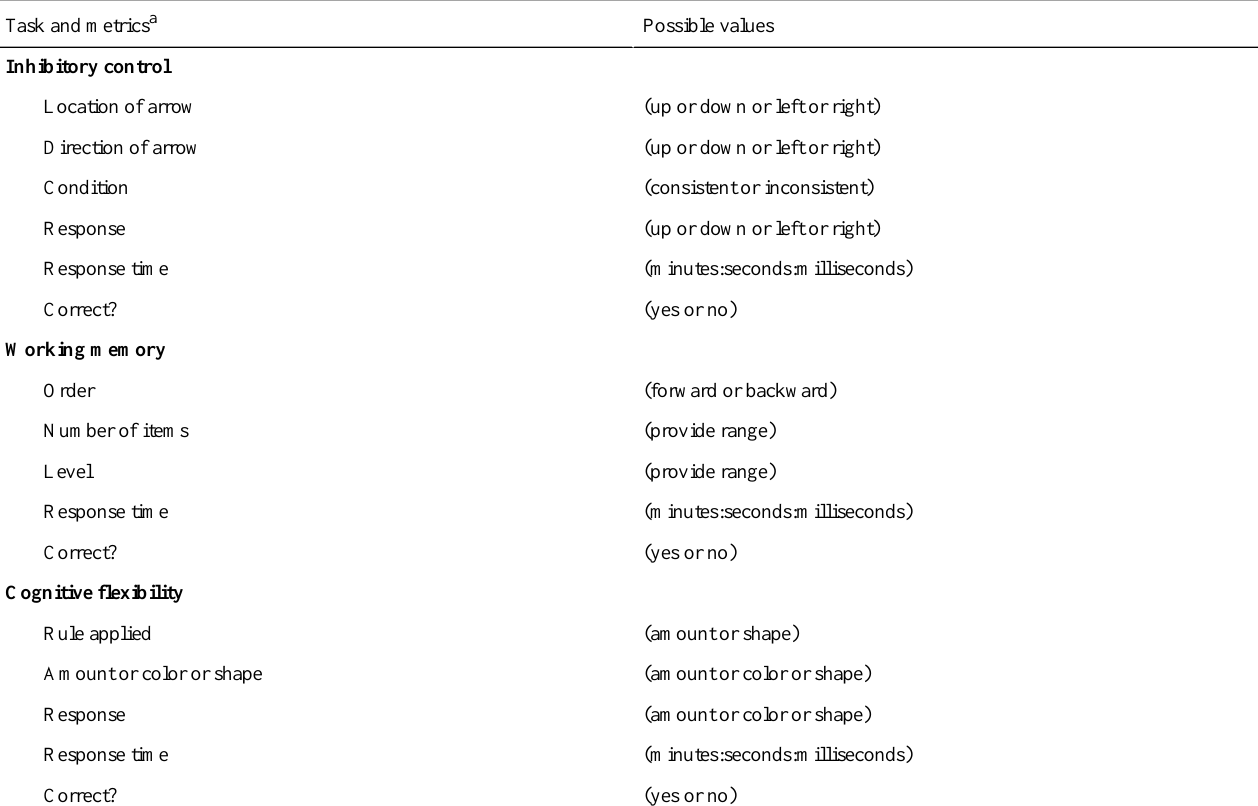
Possible valuesTask and metrics a